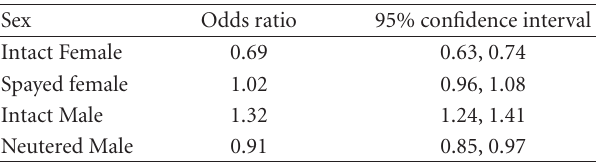
Table 2: Odds Ratio and 95% Confidence Intervals for the paired (breed and age) data for Canine Lymphoma in the VMDB (1964–